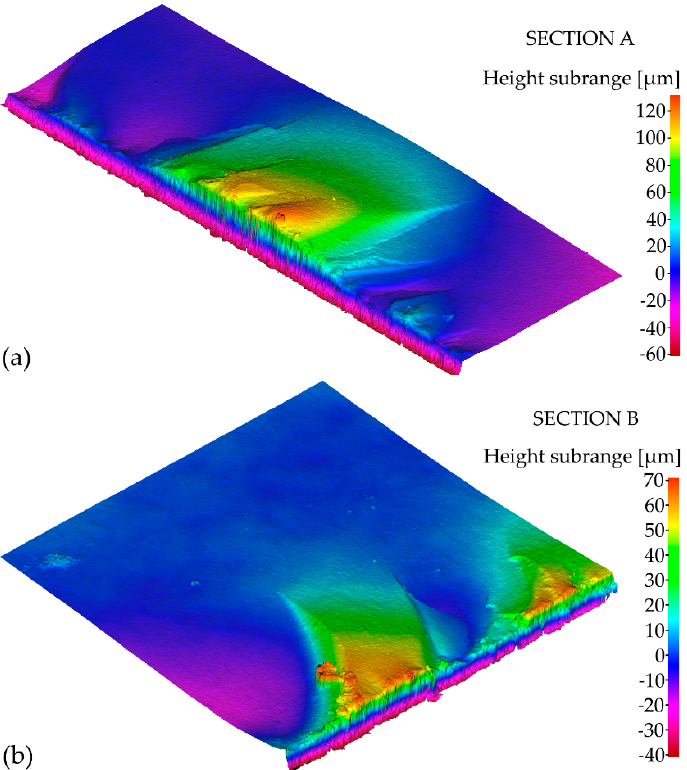
Figure 8. 3D contour diagrams for: ( a ) section A; ( b ) section B of the fracture surface after impact test.